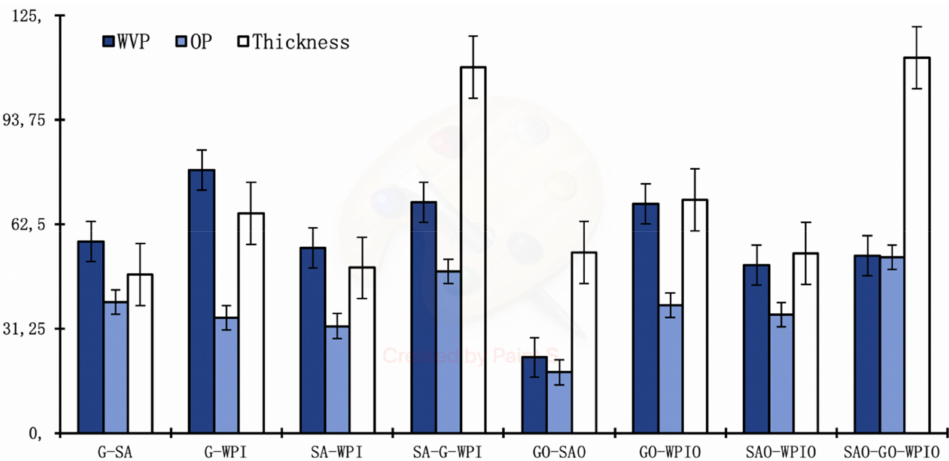
Figure 2. Values of WVP (g mm / m2 d kPa), OP (cm 3 µ m / m 2 d kPa) and the thickness ( µ m) of laminated films. Means ± standard deviation for n = 6.